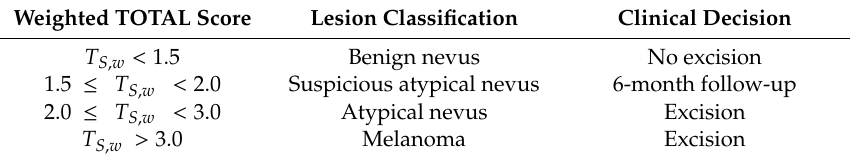
Table 3. Automatic classification according to the weighted scoring system.